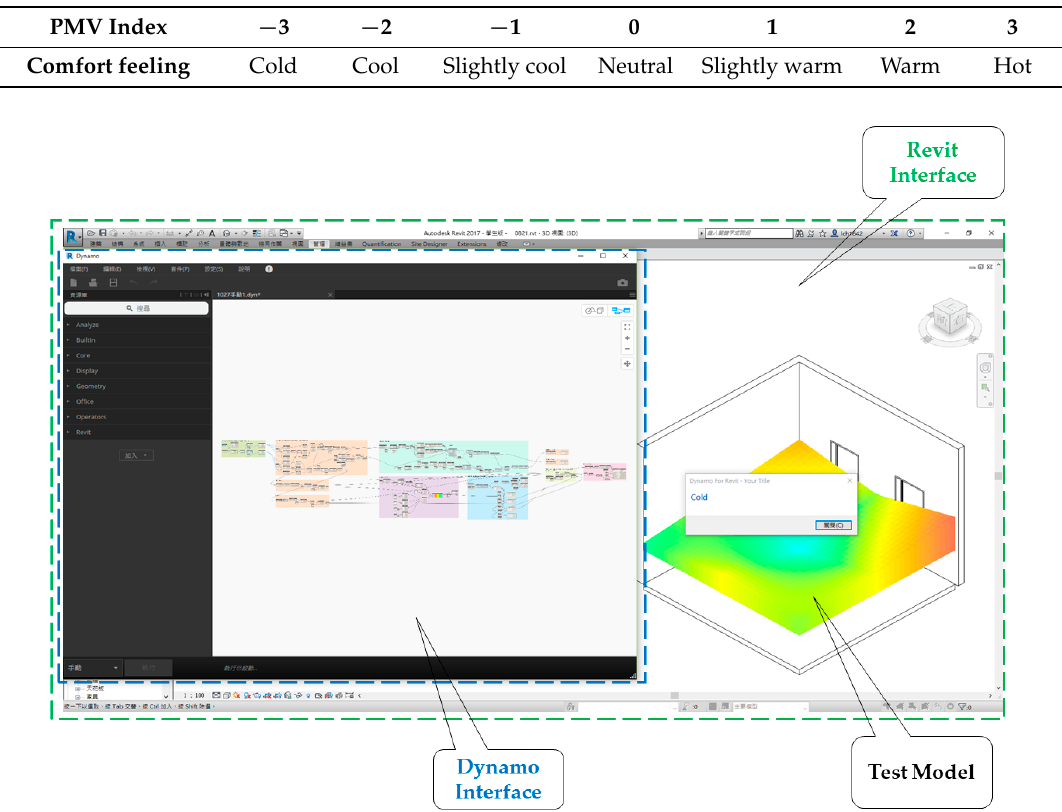
Table 2. PMV index and comfort table.